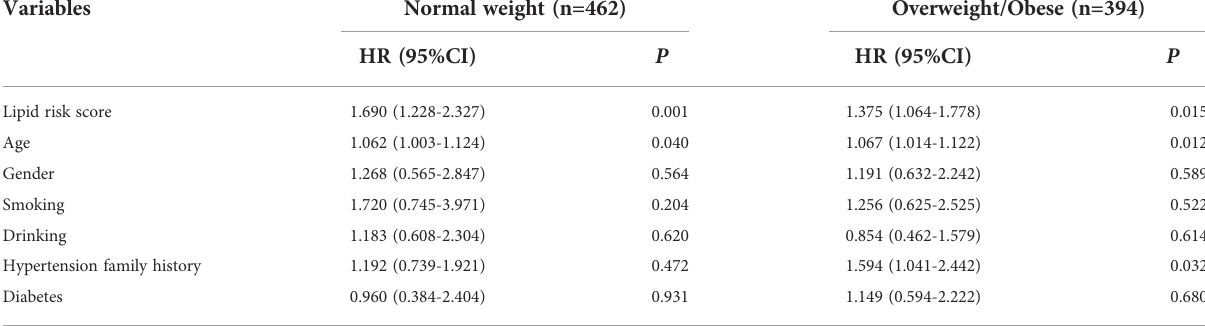
TABLE 5 Association between lipid risk score and hypertension by BMI groups.